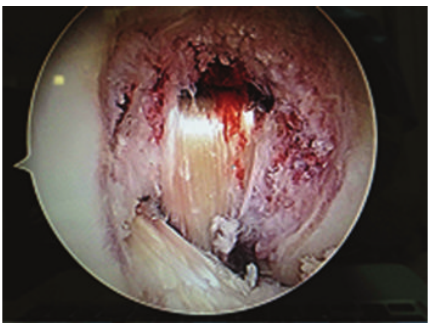
Figure 4: Perioperative view of the intracondylar notch after bicruciate